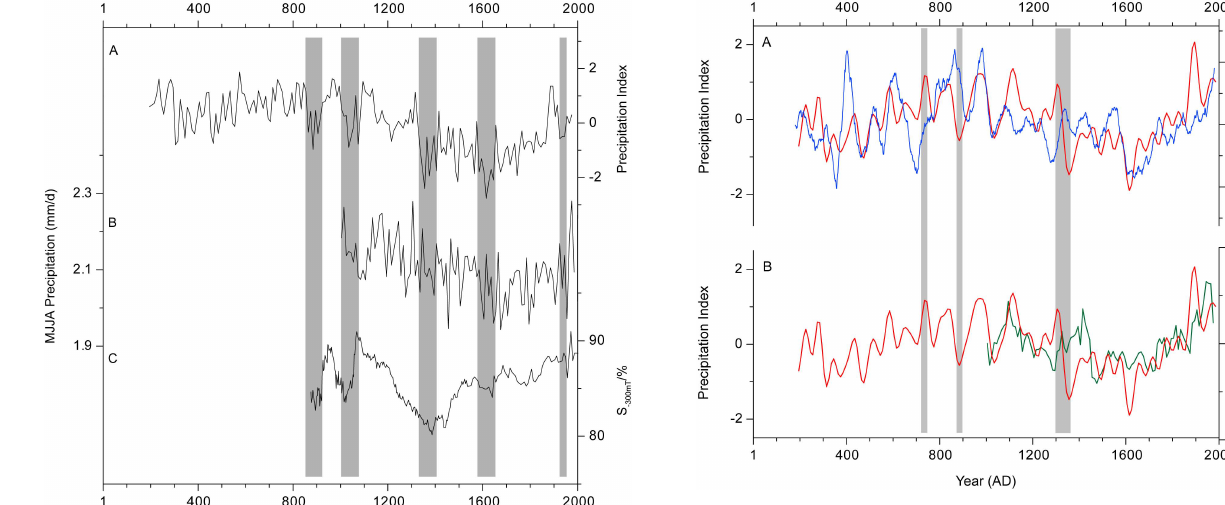
Fig. 5. Comparison of the precipitation and temperature variations in north central China during the last 1800 years. The blue line in panel (A) represents the temperature record reconstructed from tree ring in Dulan, eastern Tibetan Plateau after 40-year moving average (Liu et al., 2009). The green line in panel (B) represents the millen- nium temperature record by combining stalagmite layer series and tree ring sequence after 10-year averaged (Tan et al., 2009). The red lines in both panels represent the detrended precipitation record after 50-year low pass FFT filter. The gray vertical bars depict peri- ods characterized by discrepancies between the precipitation record and temperature reconstructions, as discussed in the